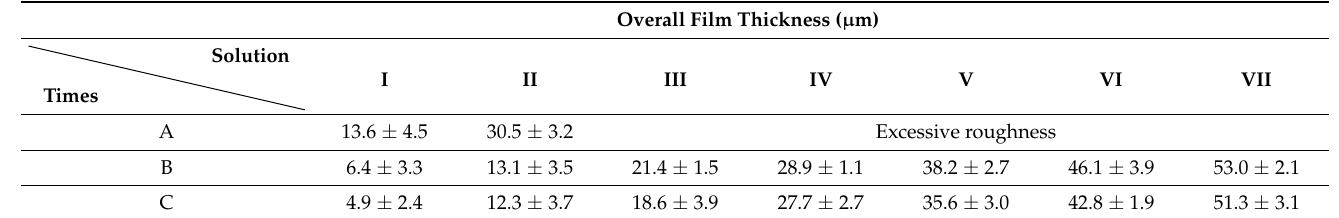
Table 2. Transfer film thicknesses, for different solutions and different coating numbers. Value represents the average ± standard deviation of 5 measurements. Accuracy of thickness: ± 2.5 µ